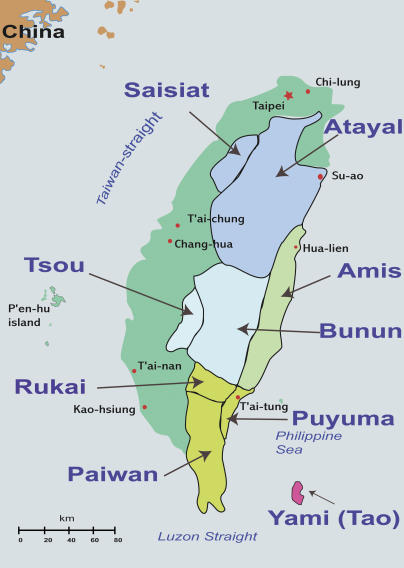
Geographic Distribution of Nine Indigenous Tribes of Taiwan